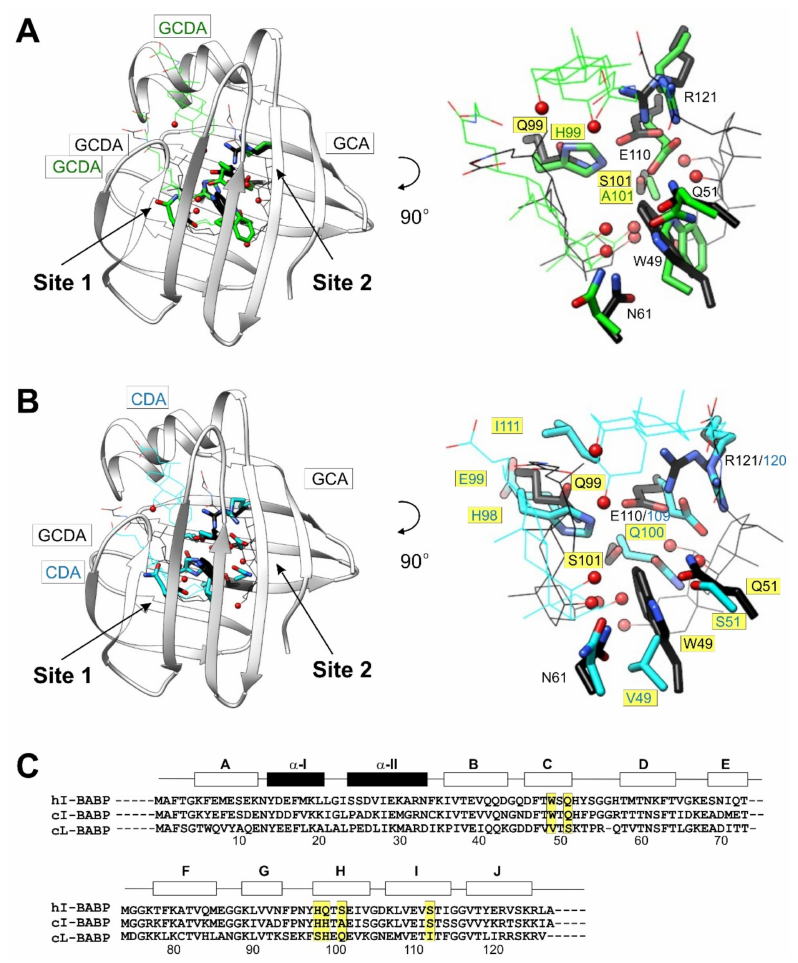
Figure 2. Key determinants of positive binding cooperativity and site-selectivity discussed in the text. Superimposed view of the binding pocket of human I-BABP:GCDA:GCA (PDB: 2mm3 [25], black) and ( A ) chicken I-BABP:GCDA:GCDA (PDB: 2lba [51], green) and ( B ) chicken L-BABP:CDA:CDA